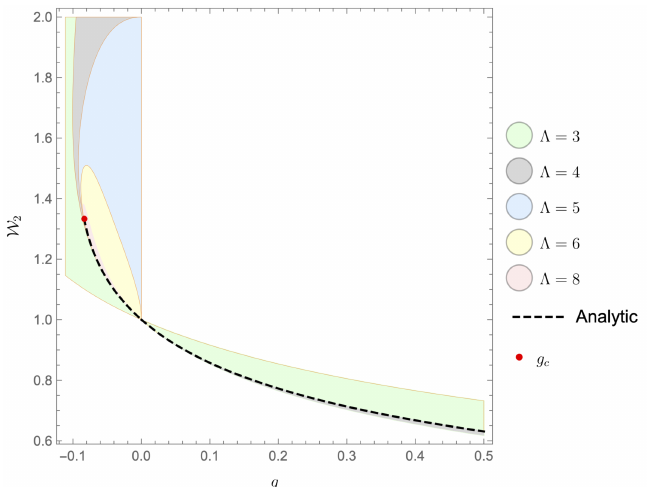
Figure 2 . The allowed region for quartic model V ( z ) = 1 with the analytic solution. Here we assuming W Λ ≥ 5 since they are almost indistinguishable from the analytic solution on the